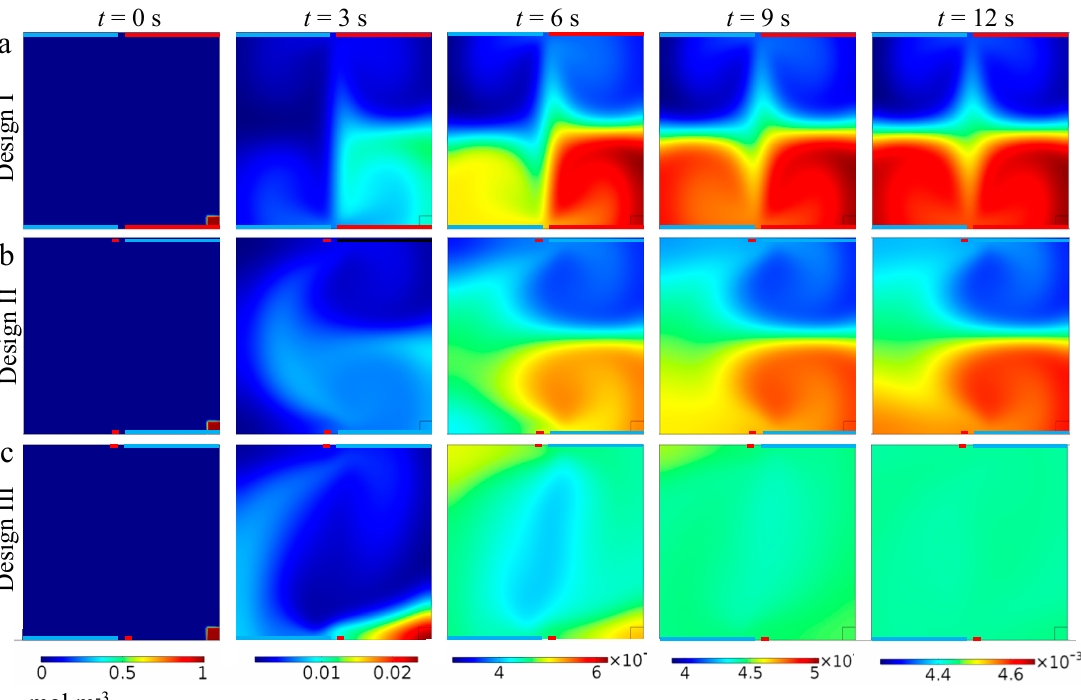
Figure 3. Concentration distribution across the channel cross-section of the ACET microfluidic device over time for the three designs. The electrodes in ( a ) have equal 140 µ m widths, while in ( b , c ), the wide electrode is 120 µ m and thin one is 20 µ m. The gap distance between electrodes for all cases is 20 µ m. An analyte with an initial concentration of 1 mol · m − 3 is introduced in a 20 × 20 µ m region at the lower right corner of surface at t = 0 (small red square). A rapid mixing within each set of microvortices is observed due to strong convection in those areas, however, analyte transfer across the regions swept by separate sets is largely limited by diffusion. As shown, a uniform distribution of analyte is achieved in the shortest time ( t = 12 s) when Design III is used.